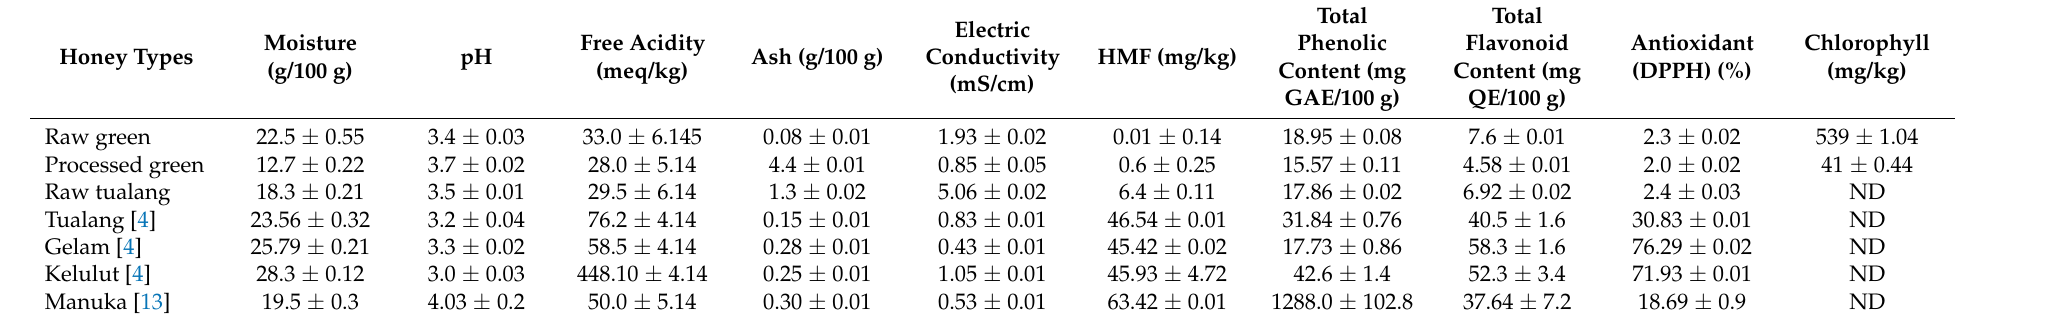
Table 1. Physicochemical analyses of green honey compared to common types of raw honey from various